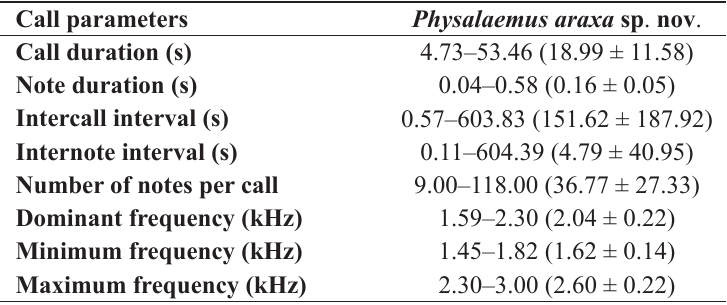
Table 3. Temporal and spectral parameters of the aggressive call from four males of Physalaemus araxa sp. nov. Values are presented as a range (average ±